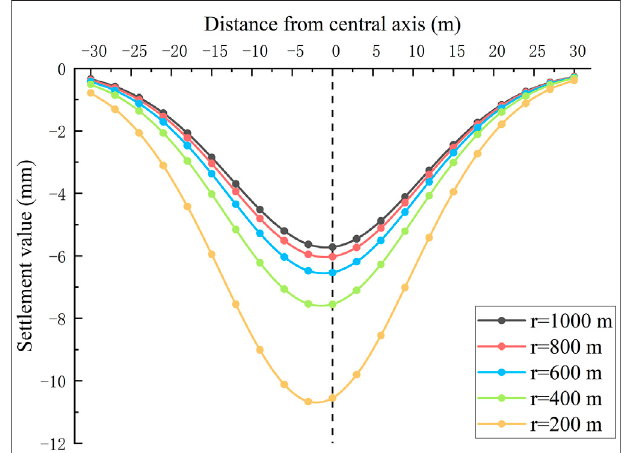
FIGURE 13 | In fl uence of different turning radii on surface deformation.